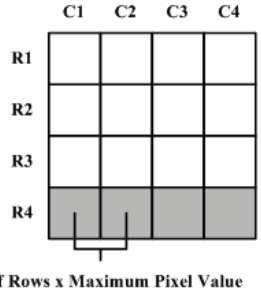
Figure 7. Internal memory requirements for the integral image computation engine for some common image sizes.